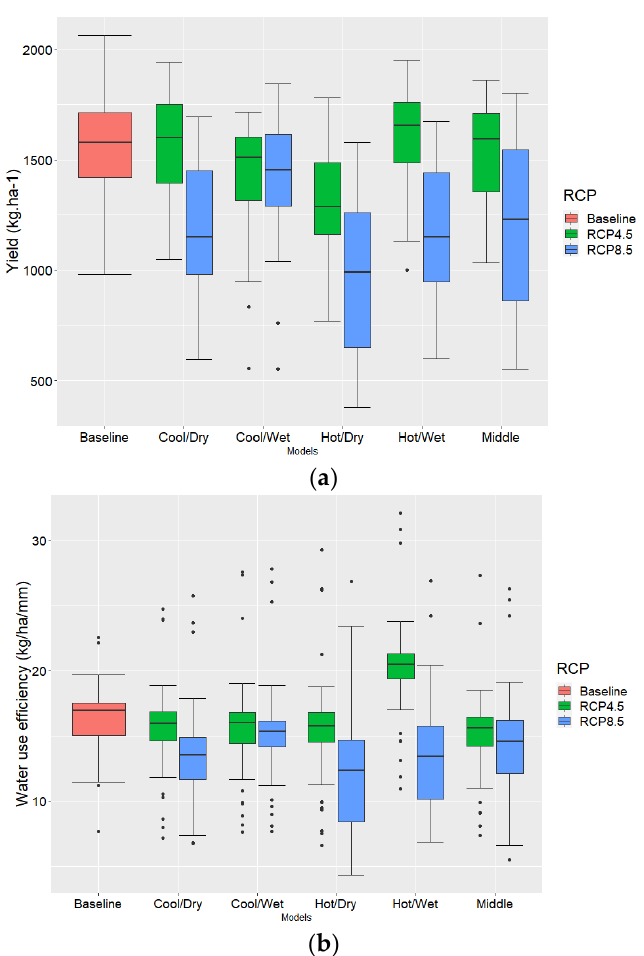
Figure 7. Climate change effect on yield and water use efficiency under two RCPs: ( a ) grain yield and ( b ) water use efficiency .